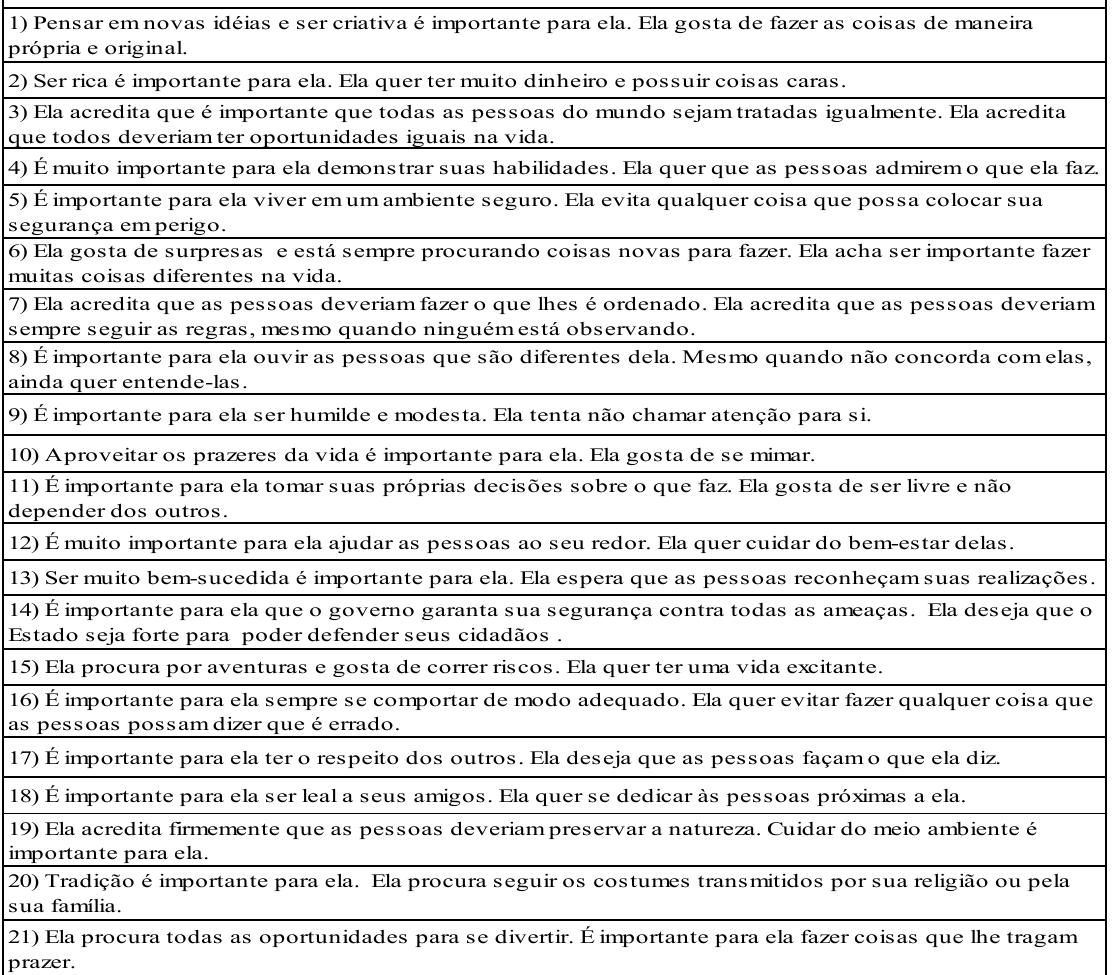
Figura 2. Assertivas do PVQ-21 em português do